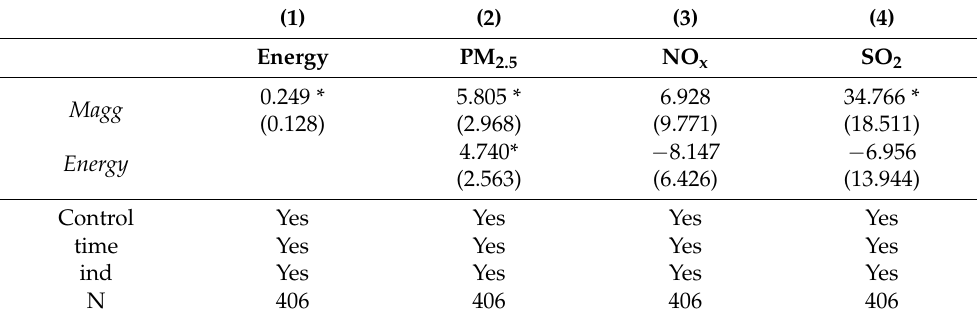
Table 12. Test of the mediating role of energy consumption structure in the agglomeration of manufacturing.